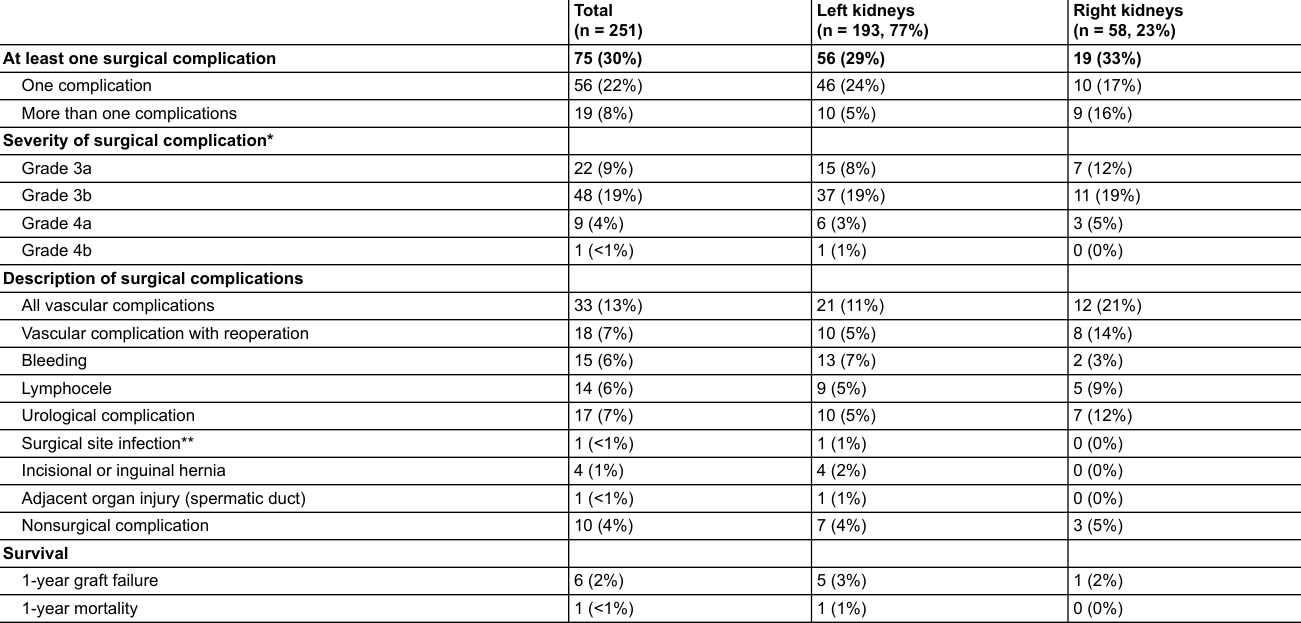
Table 2: Surgical complications Clavien-Dindo ≥3, 1-year graft failure and mortality, n (%).